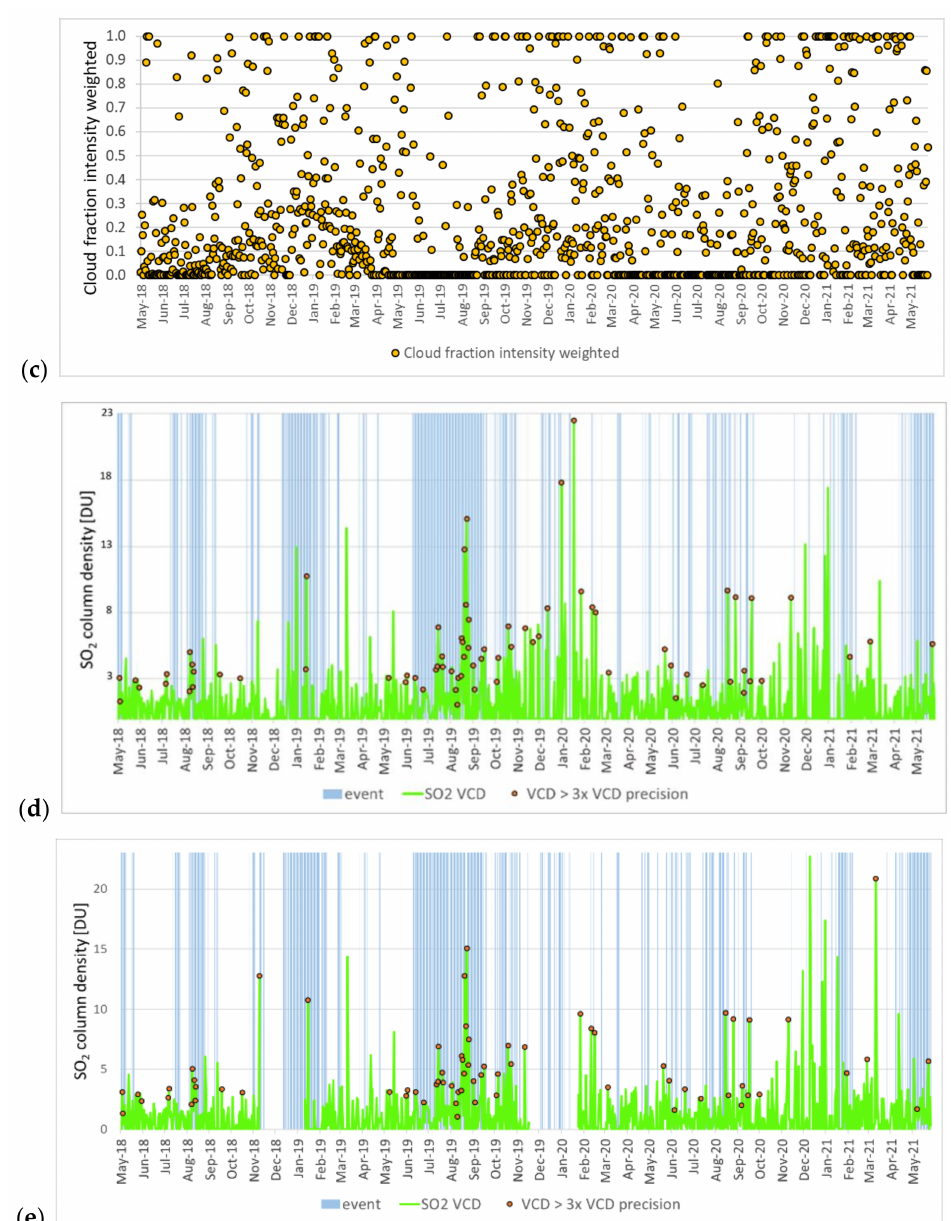
Figure 2. ( a ) TROPOMI sulfur dioxide (SO 2 ) vertical column density (VCD) observations and respective error bars (standard deviation) in May 2018–May 2021 at Stromboli (38.79 ◦ N, 15.21 ◦ E). ( b ) Quality Assurance (QA) values and ( c ) “cloud flag” associated with SO 2 data. ( d ) SO 2 VCD observations after QA and ( e ) best quality data selection filtering, with indication of the periods of intense volcanic activity (indicated in the plot as “event”) as per the information derived from UNIFI’s daily bulletins based on the ROC ground sensor data (see red placemark in Figure 1b for